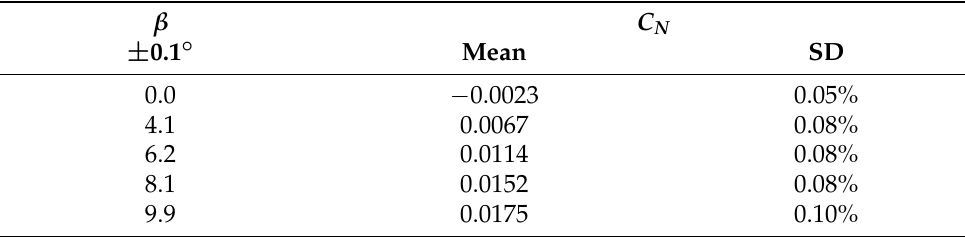
Table 4. Uncertainty in measurements of yawing moment coefficient. WBHVC configuration. Test conditions: V = 35m/s, Re = 315,000 at α =